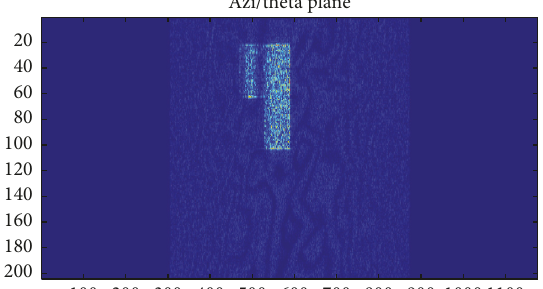
Figure 18: Original echo.